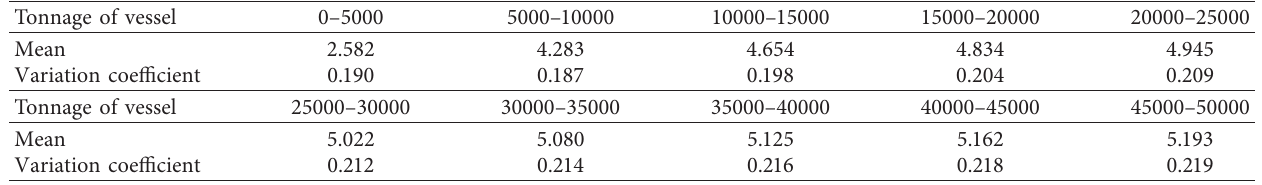
Table 3: The value of mean velocity and variation coefficient when vessels impact the main tower.